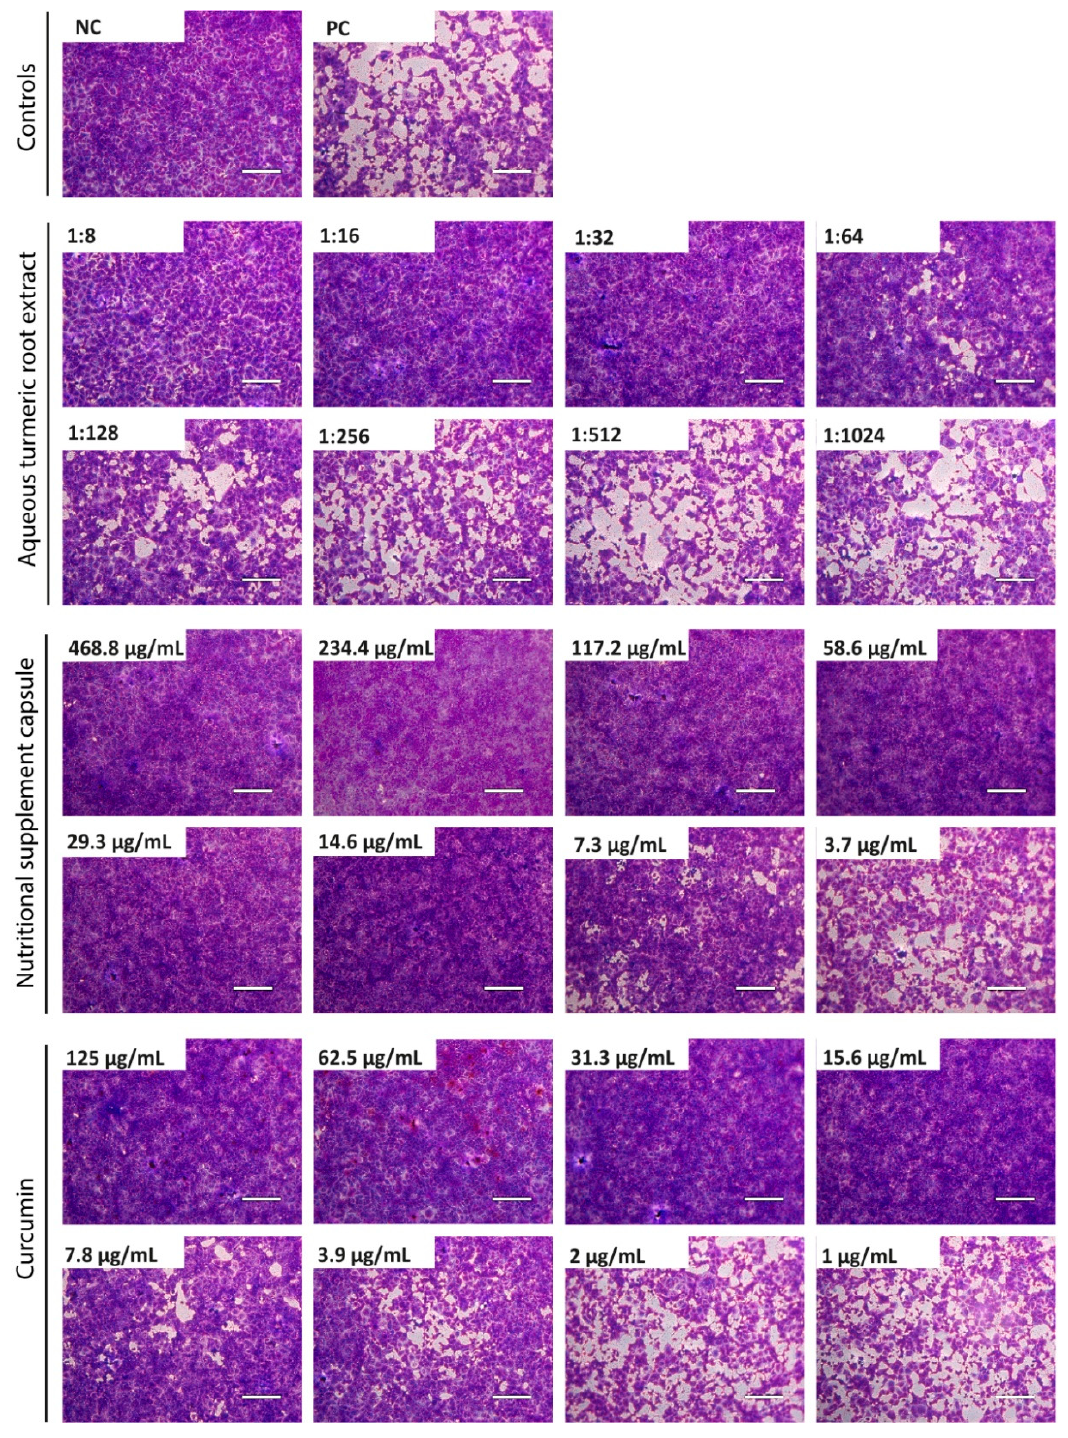
Figure 1. Neutralization of SARS-CoV-2 by aqueous turmeric root extract, curcumin-containing nutritional supplement capsules, and curcumin. Decreasing concentrations of aqueous turmeric root extract (1:8–1:1024 dilution), nutritional supplement capsules (468.8–3.7 µg/mL), and curcumin (125–1 µg/mL) were pre-incubated with 100 TCID 50 of SARS-CoV-2 for one hour and subsequently added to confluent Vero E6 cells. After 48 h, cells were stained with crystal violet and analyzed for cytopathic effects using transmitted light microscopy. The experiment was performed three times independently. Representative images are displayed. NC = negative control (medium); PC = positive control (100 TCID 50 SARS-CoV-2); scale bar = 200 µ